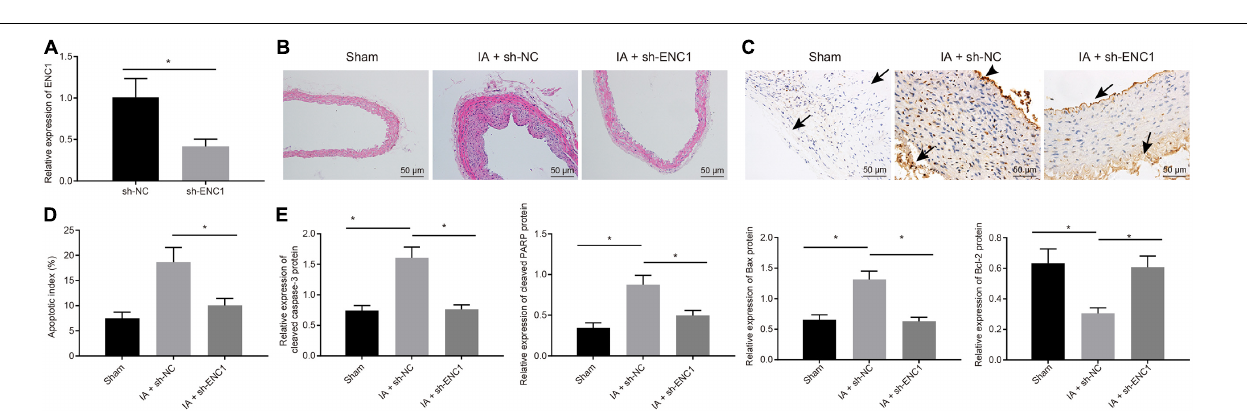
FIGURE 5 | MIAT silencing inhibits endothelial cell apoptosis and maintains endothelial cell continuity in IA rats. Rats were induced with IA model and treated with sh-MIAT or sh-NC, with the sham-operated rats as control. (A) The expression of MIAT in rats determined by RT-qPCR. (B) HE staining ( × 200) for the ACA/OA branch sections of rats. (C) The representative images of the IA wall of ACA/OA branch of rats ( × 200) (arrows indicate the arterial wall). (D) Quantitative analysis of cell apoptosis in rats assessed by TUNEL staining. (E) The expression of apoptosis-related factors (cleaved Caspase-3, cleaved PARP1, Bax, and Bcl-2) as determined by Western blot analysis and quantified by the Image J software. * p < 0.05. The measurement data were expressed as mean ± standard derivation. Comparisons among multiple groups were analyzed by one-way ANOVA followed by Tukey’s post hoc test, and the cell experiment was conducted three times independently. The sham group: n = 12, the IA + sh-NC group: n = 12, and the IA + sh-MIAT group: n = 6.